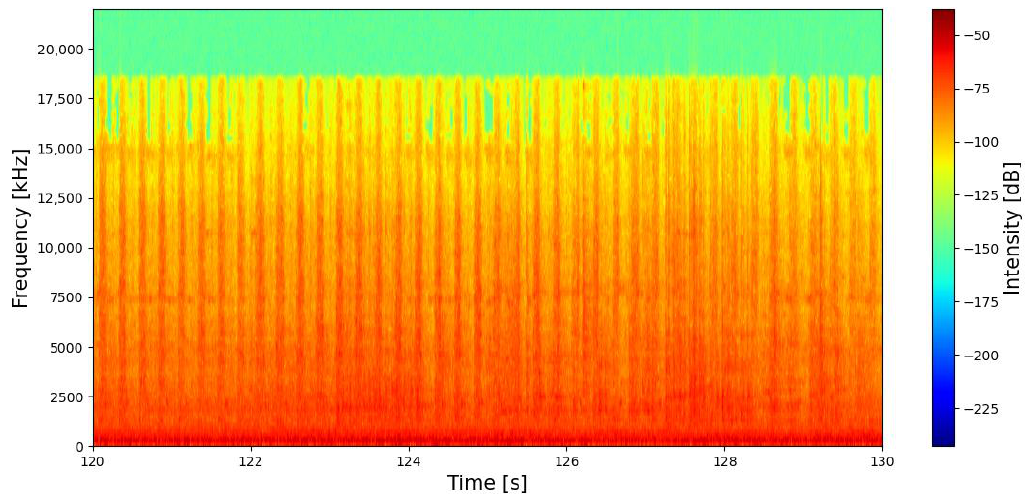
Figure 2. Spectrogram of audio signal collected in the neighborhood of incorrect operation of idler set.